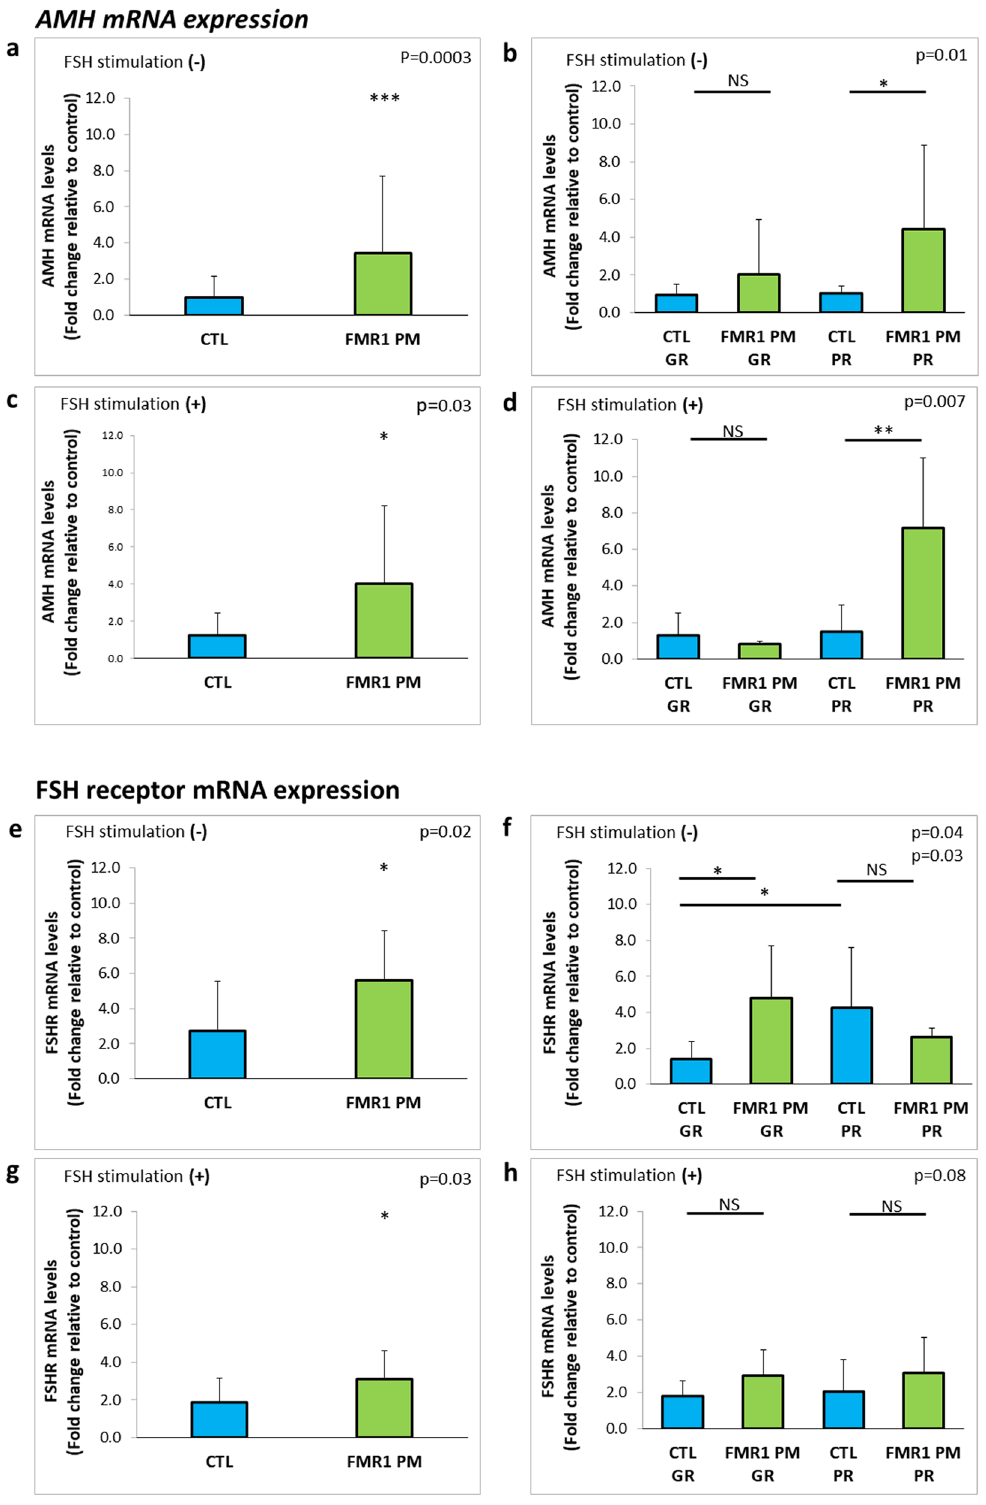
Figure 1. Higher AMH and FSH receptor expression levels in MGCs of FMR1 premutation carriers compared to MGCs of noncarriers. ( a ) AMH and ( e ) FSH receptor mRNA expression levels in MGCs of FMR1 premutation carriers ( FMR PM) and non-carriers (CTL) without FSH stimulation. ( b ) AMH and ( f ) FSH receptor mRNA expression levels in MGCs in sub-groups according to the oocytes number retrieved in OPU; GR > 5, PR ≤ 5. ( c ) AMH and ( g ) FSH receptor mRNA expression levels in MGCs following 48 h of FSH stimulation. ( d ) AMH and ( h ) FSH receptor mRNA expression levels in FSH-stimulated MGCs by number of oocytes number retrieved in OPU: GR > 5, PR ≤ 5. *p < 0.05, **p < 0.01, ***p < 0.001. Graphs show fold change in expression relative to control ±